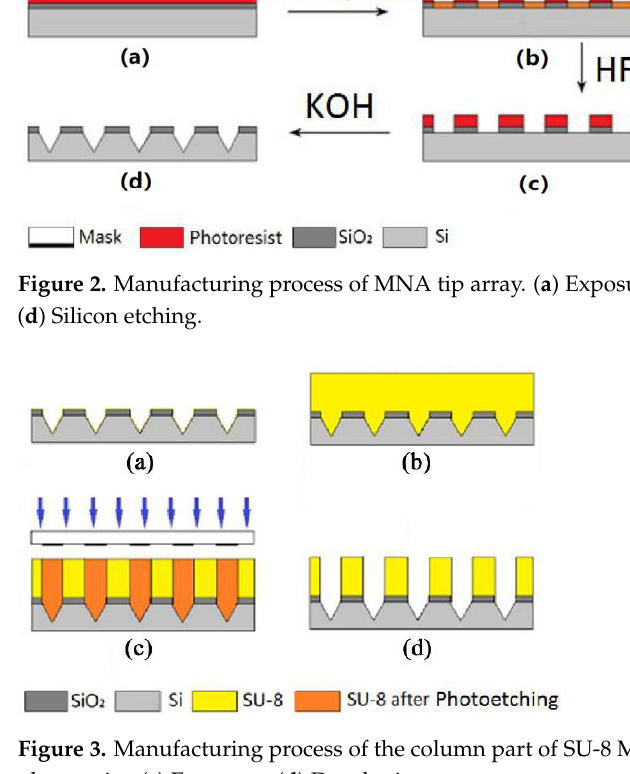
Figure 3. Manufacturing process of the column part of SU-8 MNA. ( a ) Silicon tip. ( b ) Overlay SU-8 photoresist. ( c ) Exposure. ( d ) Developing.